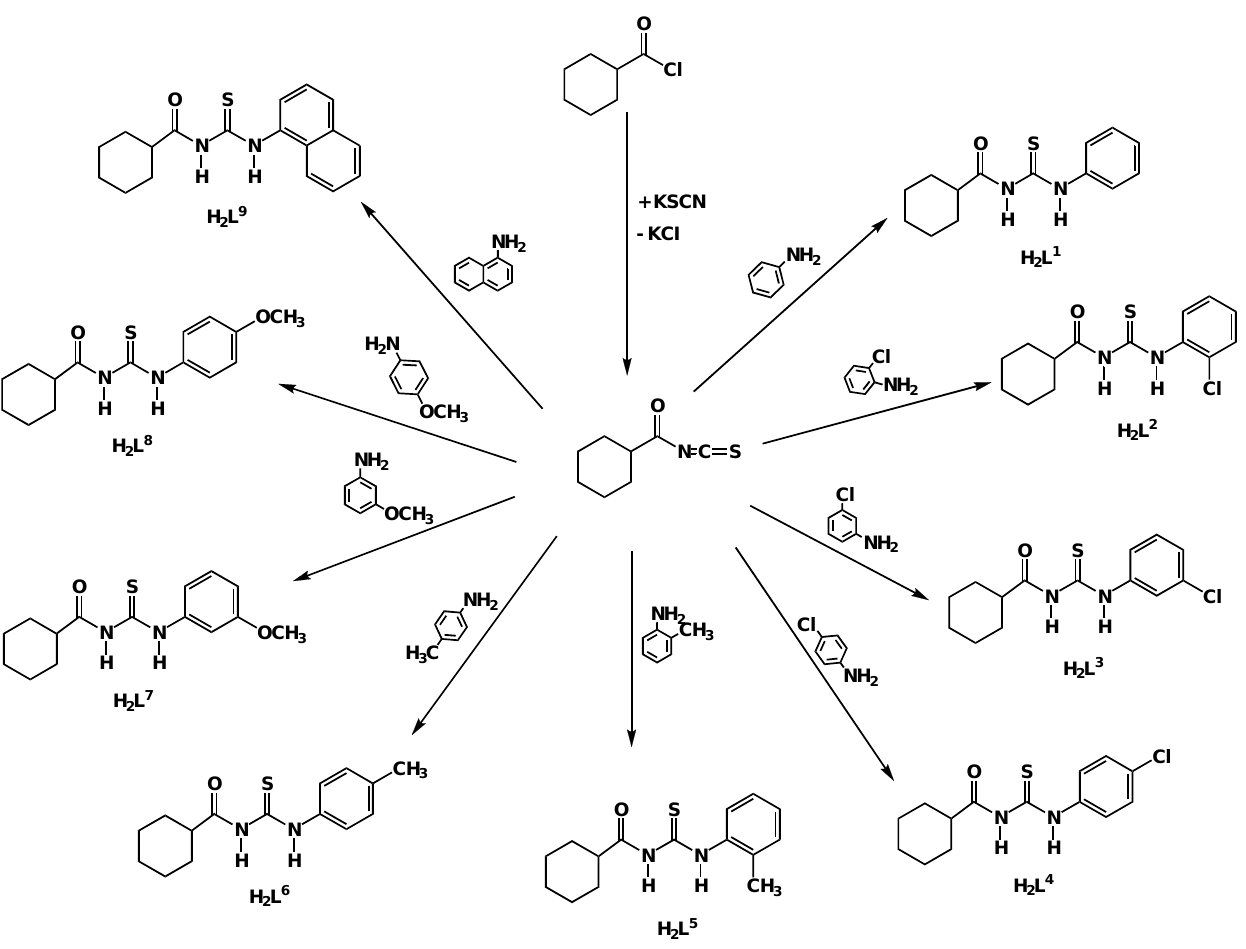
Figure 1. Syntheses of the